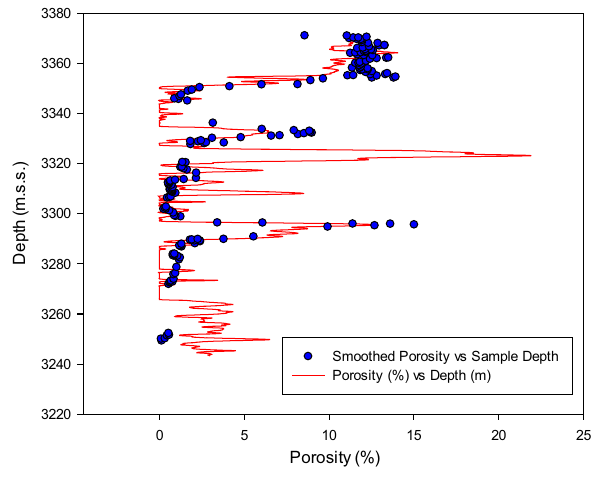
Fig. 1 Depth match of porosity from core and log data. This is plotted to certify well log interpretation along with CCAL test